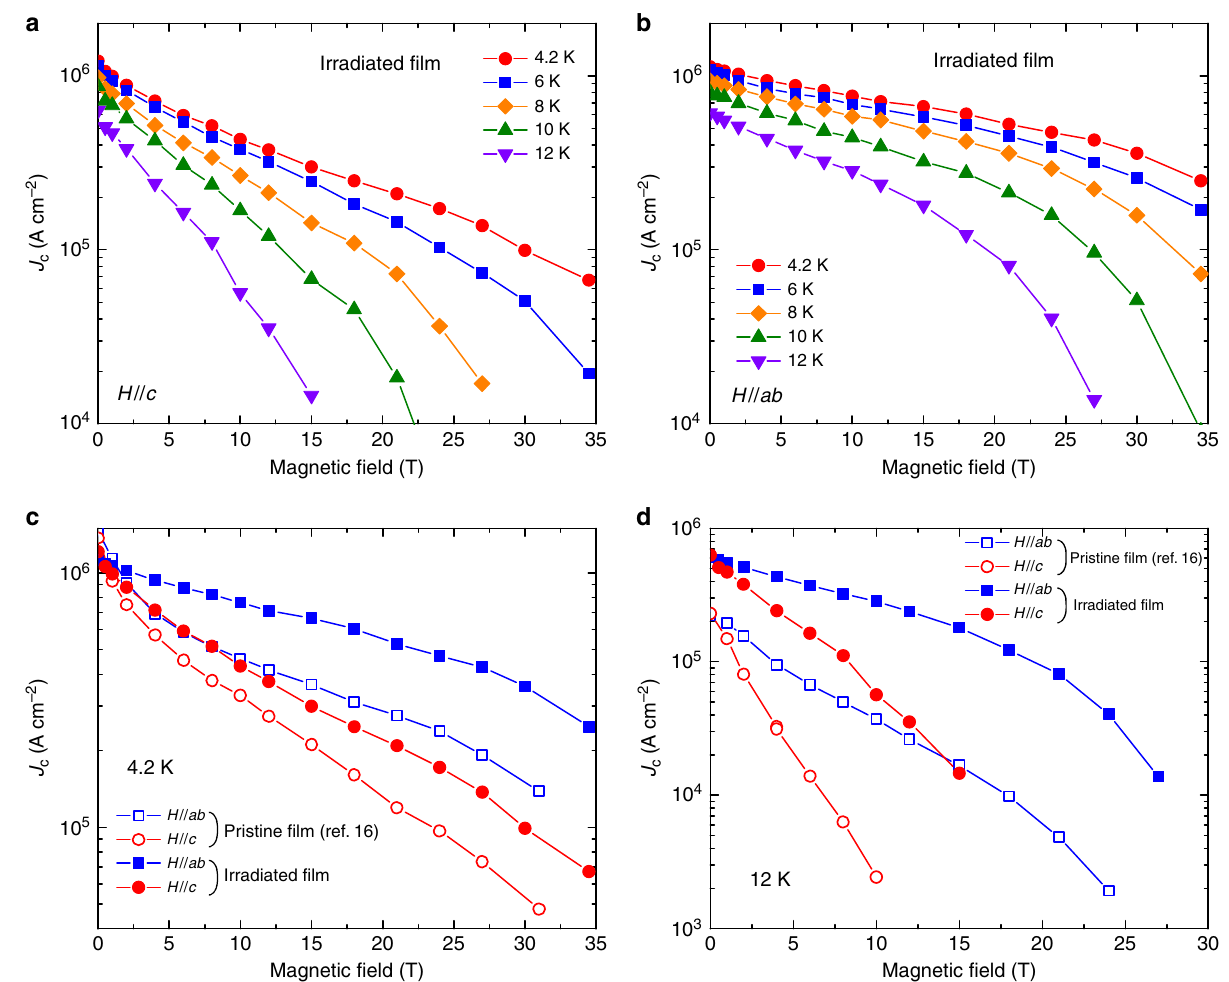
Figure 6 | High-field critical current density up to 34.5T. ( a , b ) J c ( H ) for proton-irradiated FST film with 1 (cid:2) 10 15 pcm (cid:3) 2 dose at different temperature up to 34.5Twith H // c and H // ab , respectively. ( c , d ) J c ( H ) for the irradiated FST film up to 34.5Tcompared with the pristine FST film 16 at 4.2 and 12K, respectively.